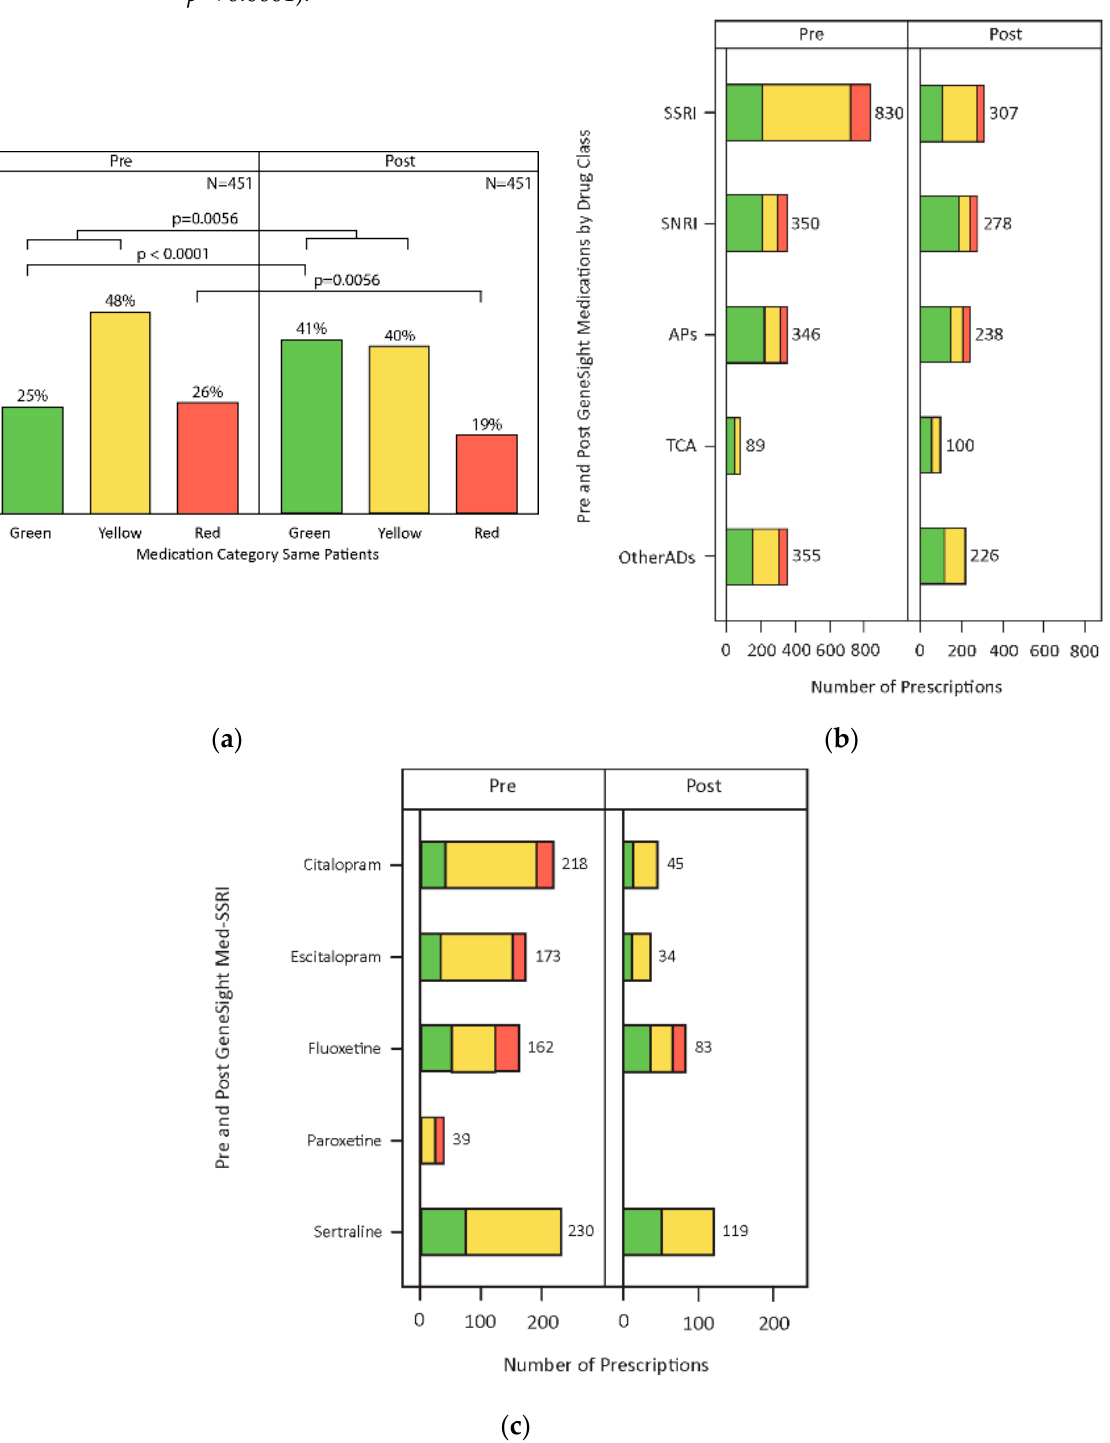
Figure 2. Medication congruency pre- and post-PGx testing. ( a ) There was a significant reduction in individuals taking incongruent medications post-PGx testing. ( b ) The greatest reduction in medication class was that of SSRIs. ( c ) Es/Citalopram had the greatest reduction in prescriptions post-PGx testing.